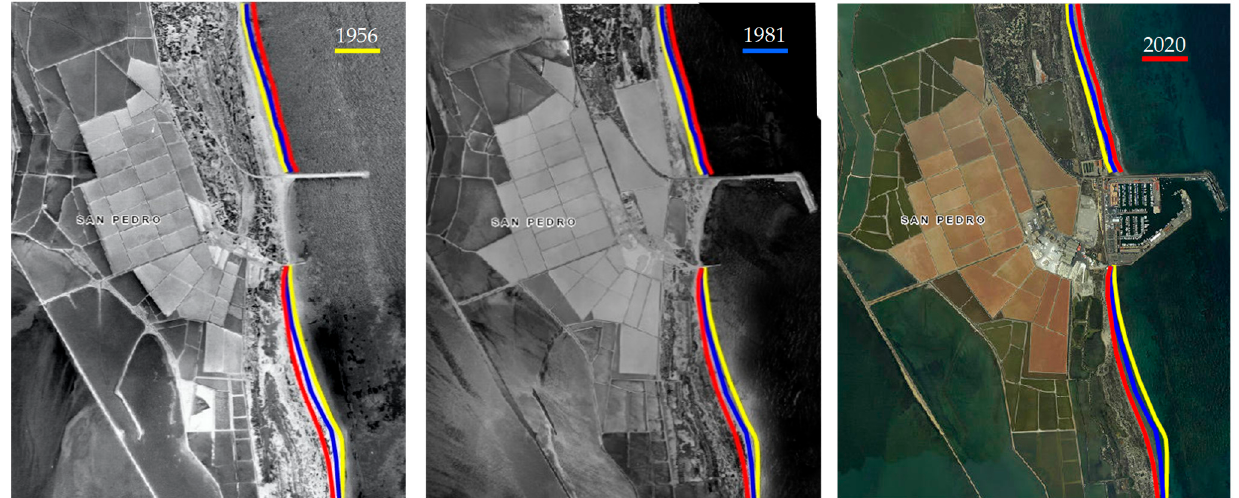
Figure 7. Differences between north and south side asymmetric evolution in the San Pedro del Pinatar marina in relation to the port building impact on the sand line between 1956 and 2020.